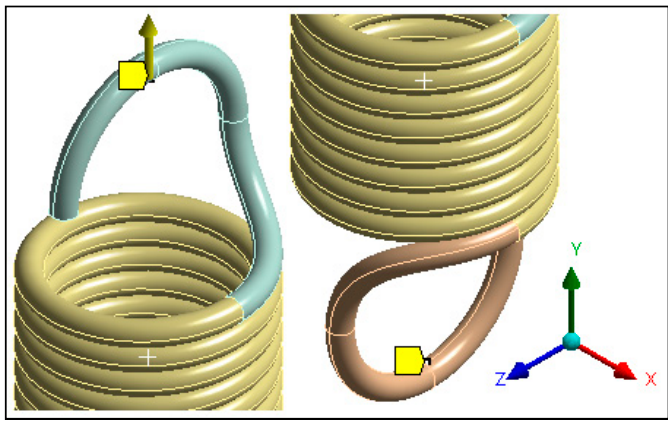
Figure 7. Boundary conditions. Table 2. Boundary conditions applied for all simulations.